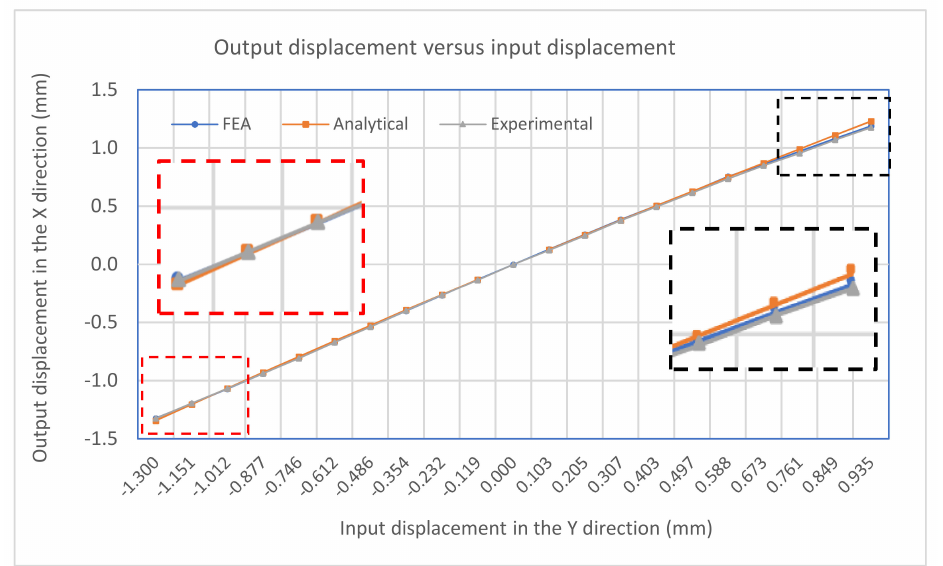
Figure 9. Input-displacement and output-displacement